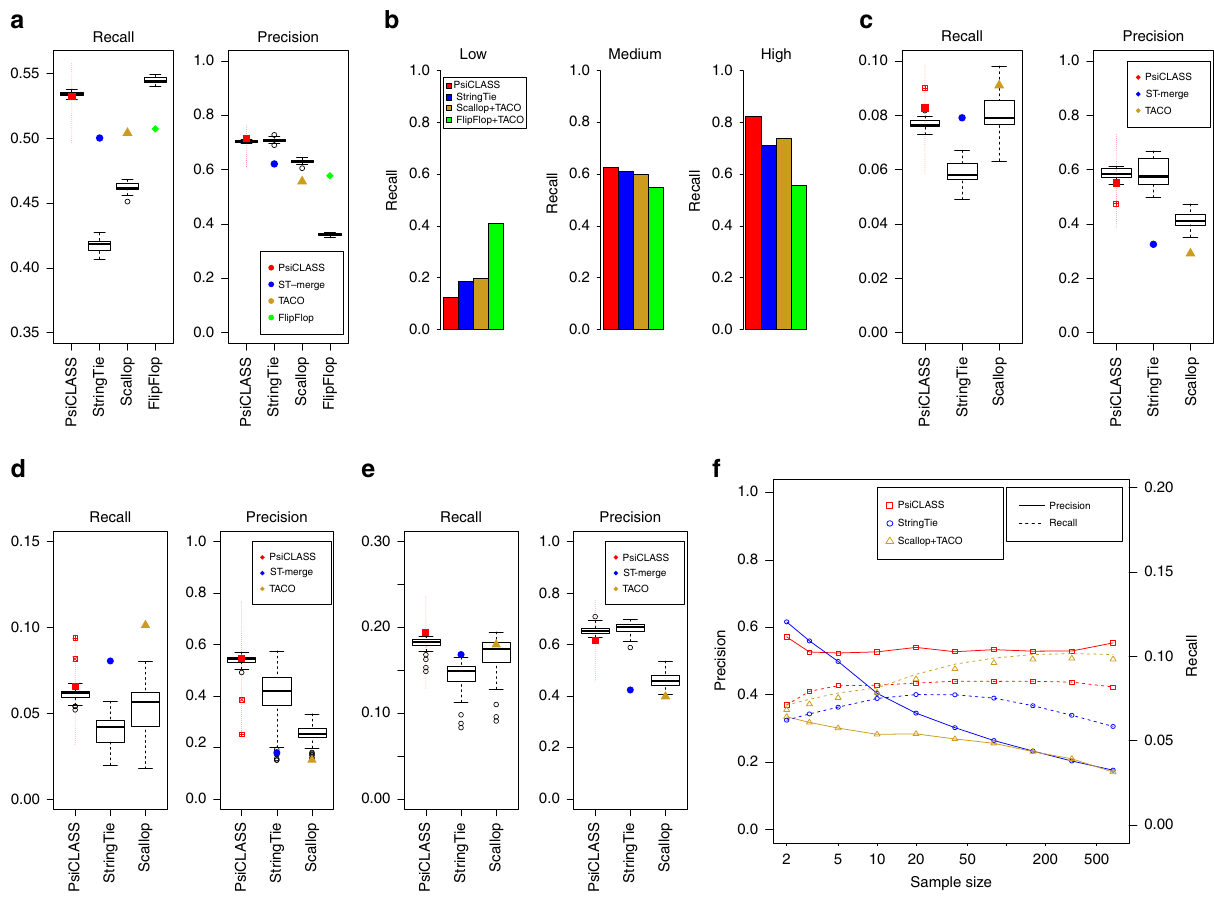
Fig. 1 Performance evaluation of methods on simulated and real data: a 25 simulated RNA-seq sets, all genes; b 25 simulated sets, genes grouped by abundance; c 25 GEUVADIS samples (polyadenylated RNA); d 73 liver RNA-seq samples (rRNA-depleted total RNA); e 44 hippocampus samples from healthy and epileptic mice; and f subsets of 1, 2, 3, 5, 10, 20, 40, 80, 160, and 320, and the full set of 667 GEUVADIS samples. In a , b – e , sensitivity (recall) and precision values for PsiCLASS, StringTie, and Scallop at the level of individual samples are shown in boxed plots, and meta-annotations resulted from aggregation (with PsiCLASS voting, ST-merge, and TACO) are shown with colored shapes. Boxplots were generated with R using default options, namely, the box extends between the lower and upper quartiles, horizontal lines mark the median, and whiskers are at the 1.5 × interquantile point above the upper quartile and bellow the lower quartile. Lastly, additional symbols mark sensitivity and precision values for PsiCLASS when tuned to match or approach the sensitivity of its competitors, along the range of cutoff values 0 – 16, shown with dotted red lines. Source data are provided as a Source Data fi a different cutoff. Even at the individual sample level, PsiCLASS ’ s performance exceeds that of its competitors ’ , with higher or comparable per sample average measurements in both compo- nents (Fig. 1c, d, boxplots).